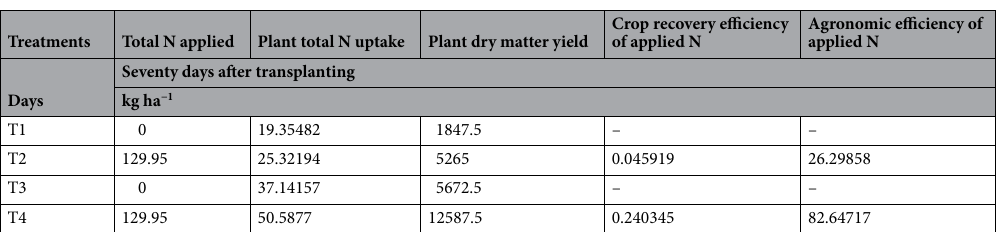
Table 20. Chicken litter biochar application and split application of urea on crop recovery and agronomic efficiency on day seventy after transplanting.